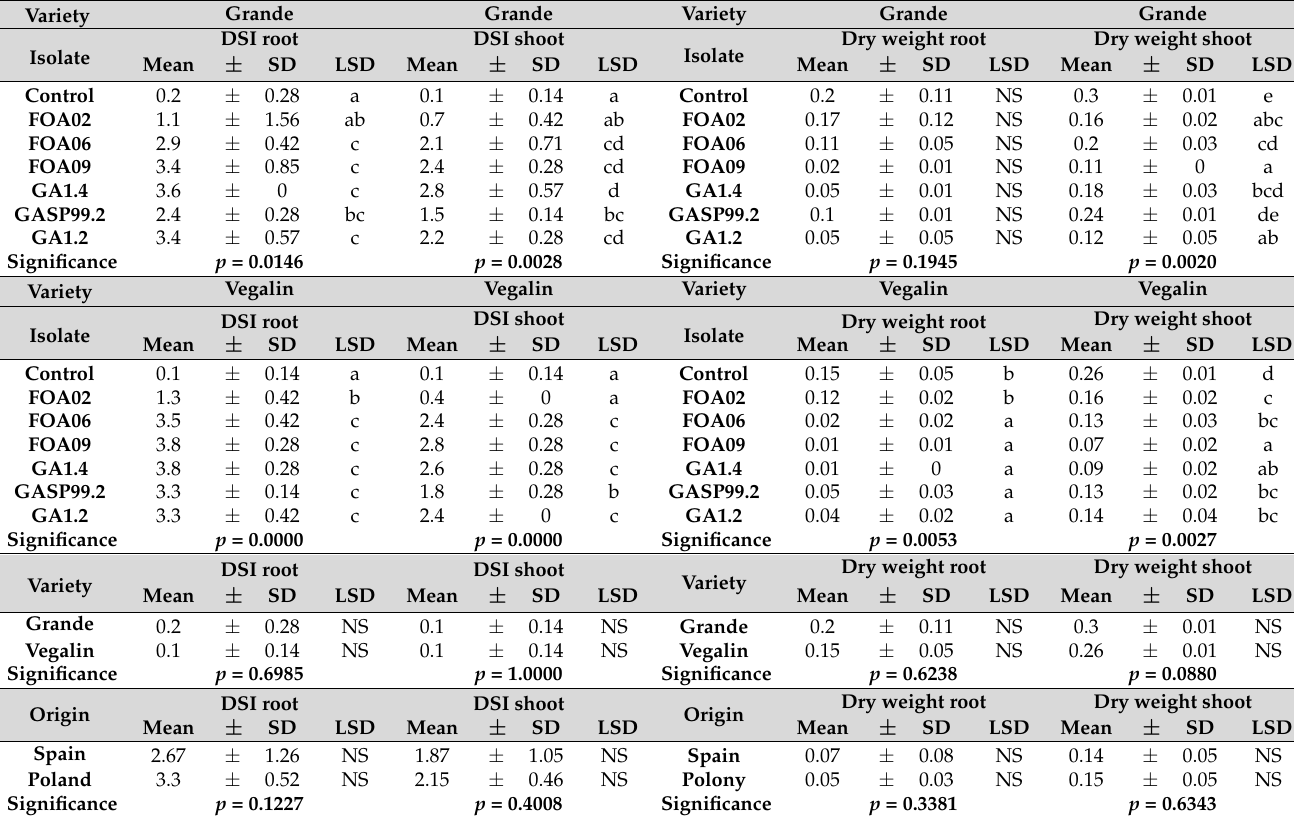
Table 3. Disease Severity Index and dry weight of asparagus seedlings following artificial inoculation with six isolates of F. oxysporum associated with vascular wilt on asparagus originating from Spain and